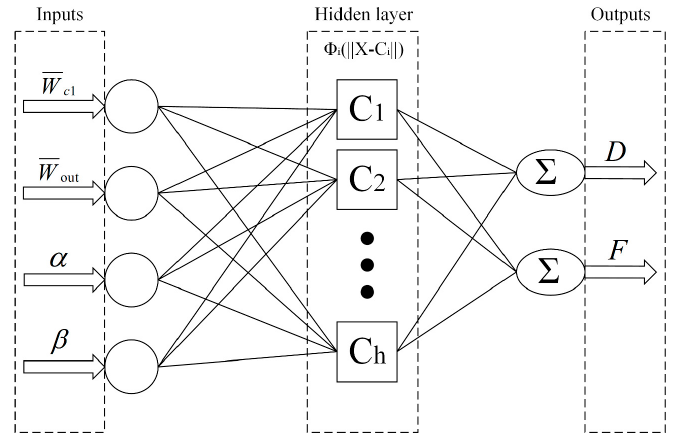
Figure 4. RBF neural network